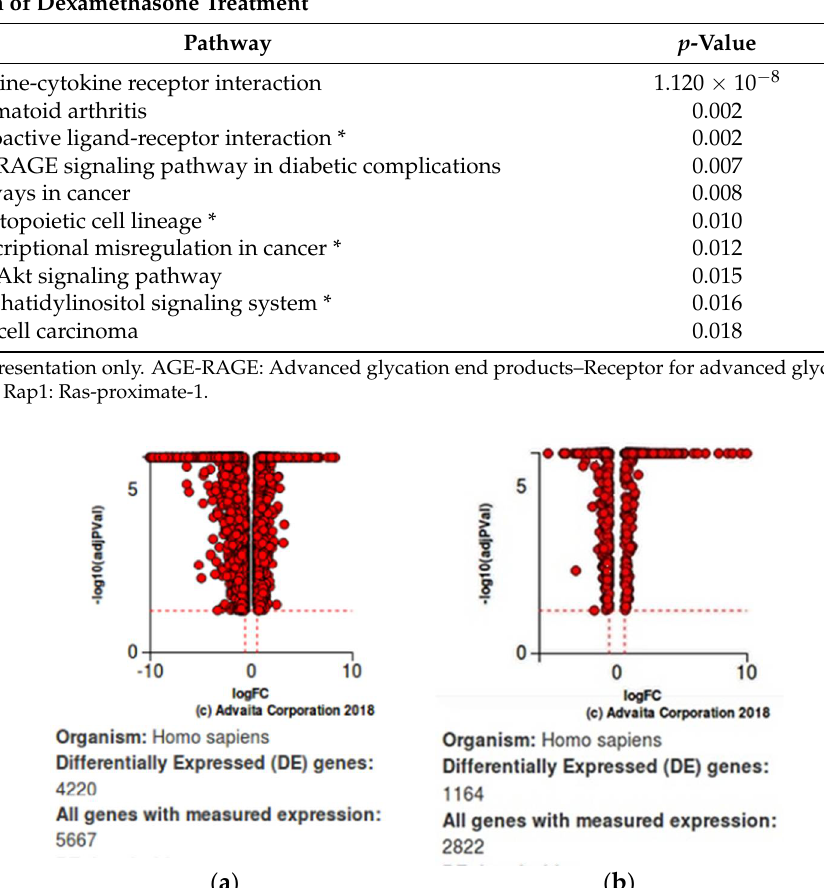
Table 4. Most significantly enriched Kyoto Encyclopedia of Genes & Genomes (KEGG) pathways for different samples.